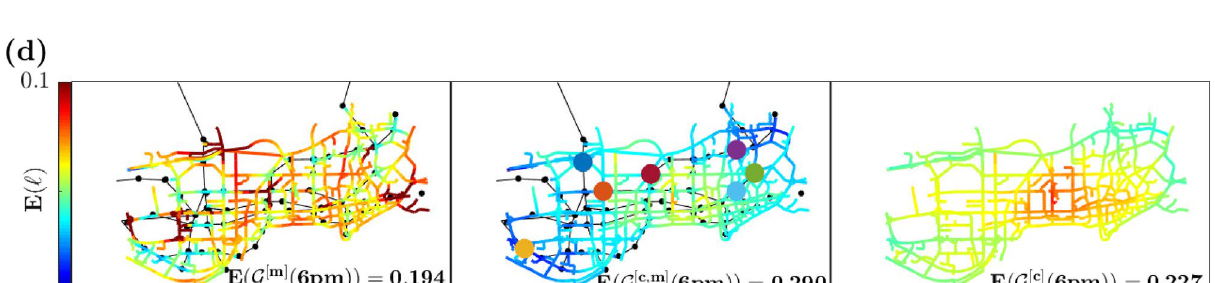
Figure 2. Temporal and spatial efficiency of an urban multimodal transportation system. ( a ) Temporal variation of the network dynamical efficiency for the city of Shenzhen (China) during a typical day (7th [ c ] September 2011). Reported are the efficiency of the single car layer ( G ) (red), the efficiency of the single metro [ m ] layer ( G ), which also considers walking and waiting times, and the peak and off peak frequency of the trains [ c,m ] (green), and the efficiency of the combined multilayer system G , with the Eq. (4) of park and ride system (blue). ( b ) The average usage of each layer, namely the percentage of all travel time spent on car or metro, in the case of the combined multilayer system. ( c ) Sum over all intermodal junctions of their station centrality , that is the number of mode changes between road and metro networks of all H-paths passing by the station. ( d ) Spatial map of link efficiency for the three networks considered in panel ( a ). Blue colors mean higher efficiency, while red indicates lower efficiency with respect to the network free-flow condition. The seven most used stations (those with the largest station centrality) at 6pm have been highlighted with the same colors as in panel ( c optimized pricing policy. In this figure, we show how much this measure is sensitive to the congestion and how it recognizes the best location to change between car and metro. This is because in severe traffic condition the presence of public transportation alternatives is more suitable, especially for the aim to protect the central zones of a city from unmanageable traffic jams. Moreover, the station centrality information and the dilemma factor defined in Eqs. (7) and (8) can be used to regulate the distribution of users in a network and avoid unexpected accumulation and, consequentially, congestion.